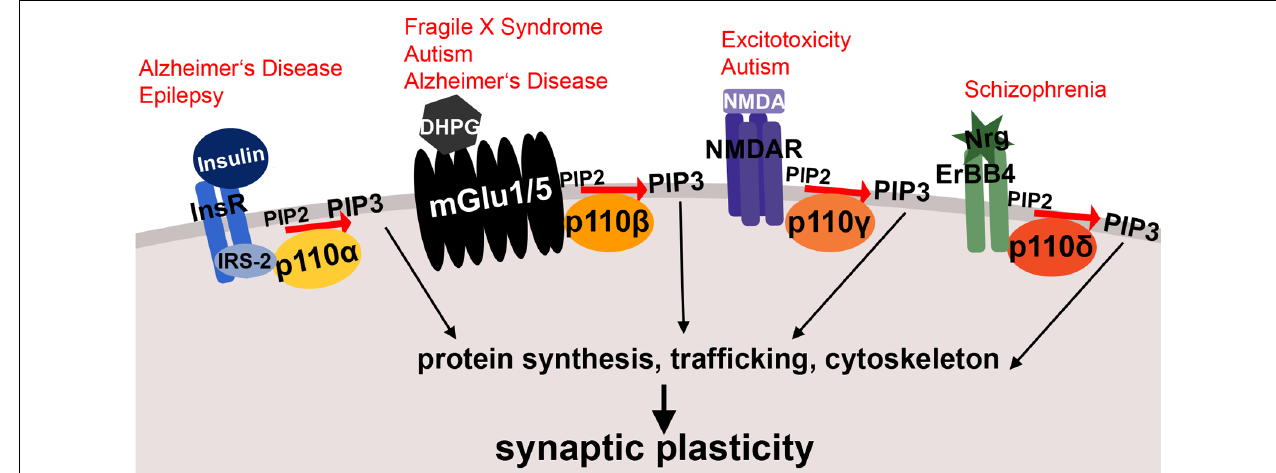
FIGURE 1 | Schematic illustrating membrane receptor-specific signaling of class I PI3K subunits and their potential link to mental disorders. Shown are examples of neuronal membrane receptors and the specific p110 catalytic subunits, through which they preferentially signal. All of these receptor-PI3K complexes were implicated in mental disorders, which are printed in red above the receptors. Both insulin signaling through p110 α and metabotropic glutamate receptor signaling through p110 β are affected in Alzheimer’s disease. Moreover, metabotropic glutamate receptor signaling through p110 β is altered in fragile X syndrome and other autism spectrum